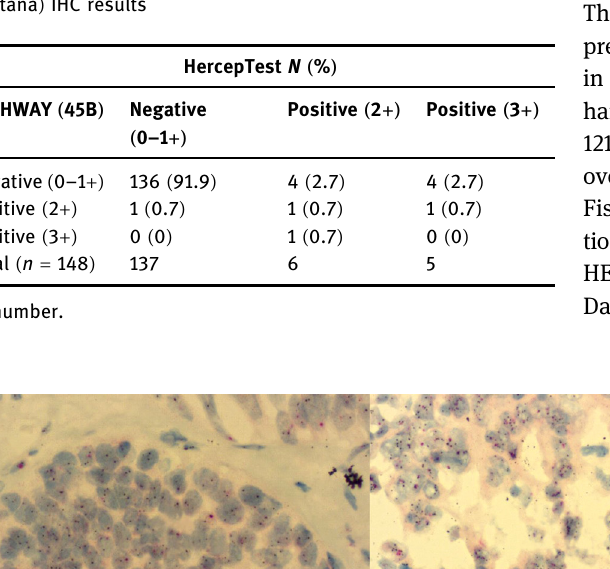
Table 2: Comparison of Hercep test ( Dako ) and PATHWAY ( 4B5 - Ventana ) IHC results